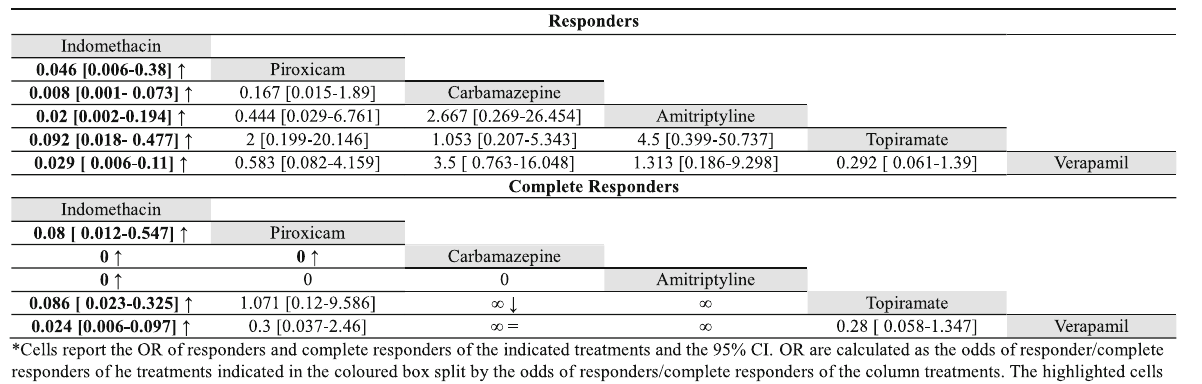
Table 5 statistical comparisons between the odds of responders and complete responders of prolonged treatments for PH*